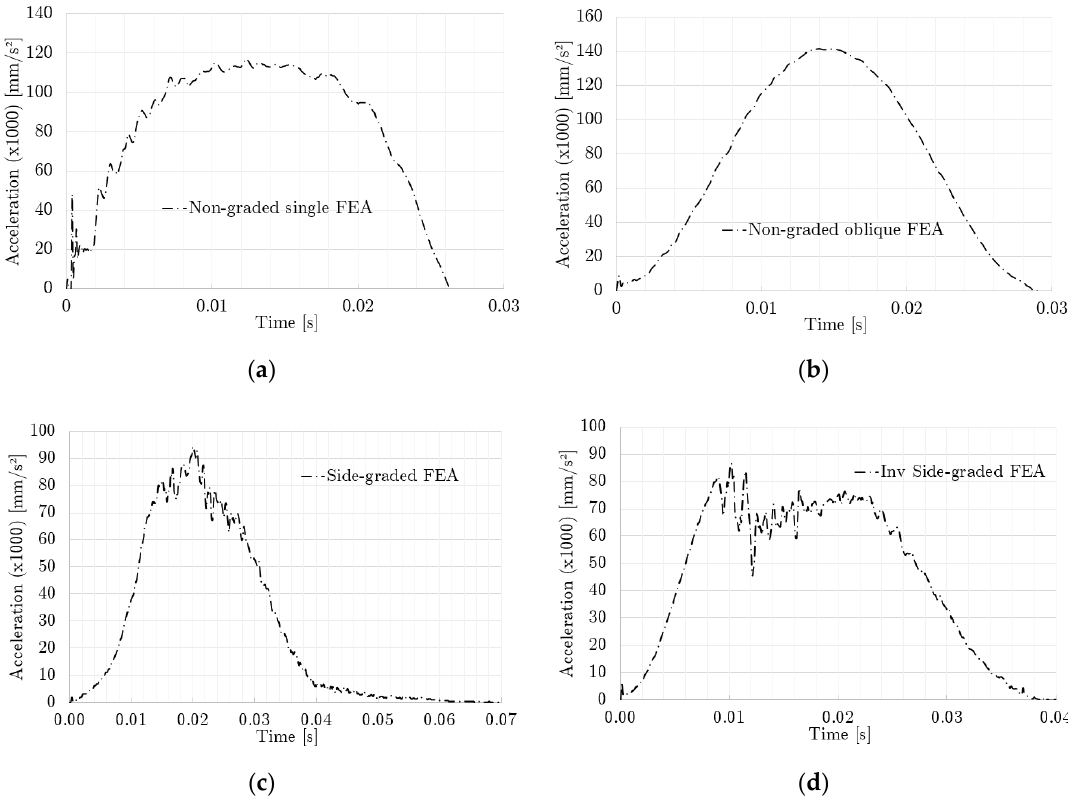
Figure 15. Acceleration history: ( a ) None-graded lattice single impact, ( b ) Non-graded lattice oblique impact, ( c ) Side-graded lattice, and ( d ) Inversed side-graded lattice. Table 3. Average